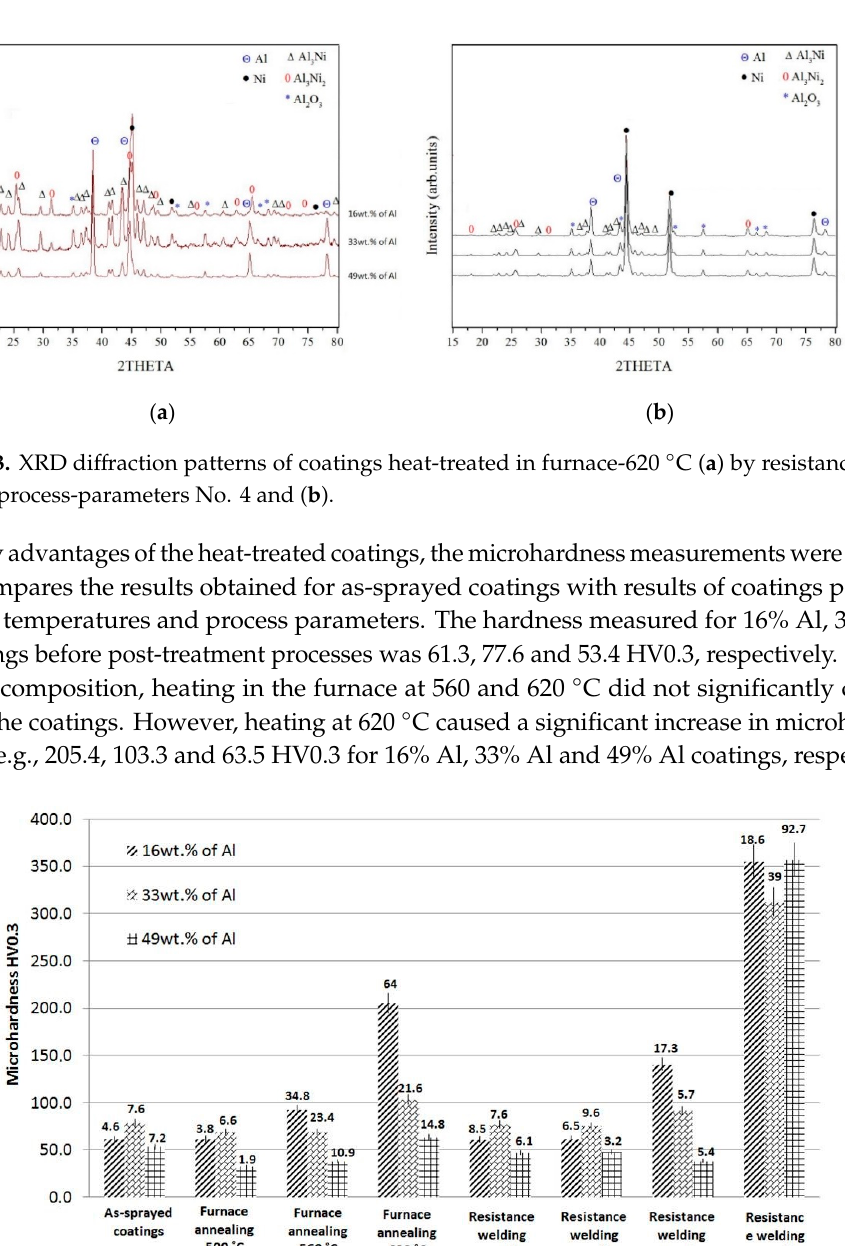
Figure 12. EDS analysis of 16% Al coating: heated in a furnace at 620 °C ( a ) and heated by resistance spot welding process with parameters 4 ( b ).